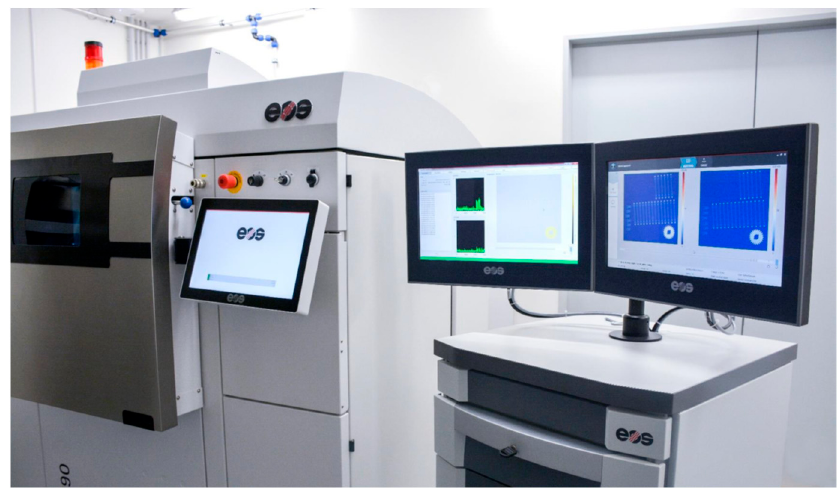
Figure 2. Selective laser sintering 3D printing machine EOS M290 used in the process of specimen preparation.